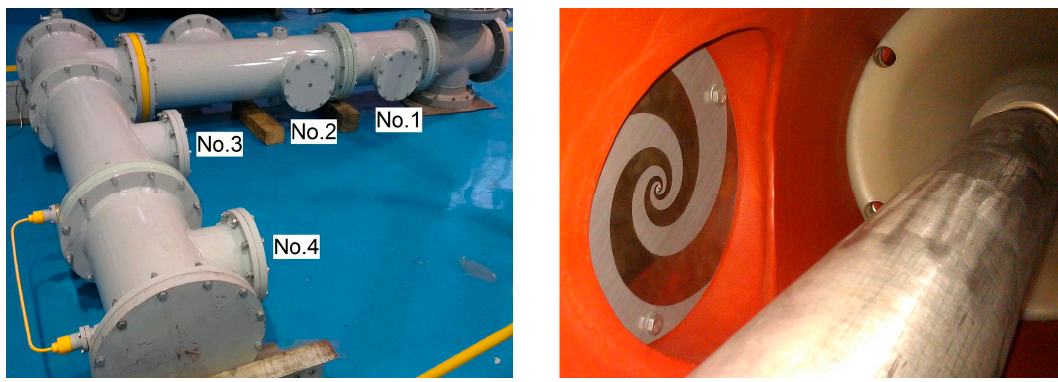
Figure 2. The placement of UHF sensor.